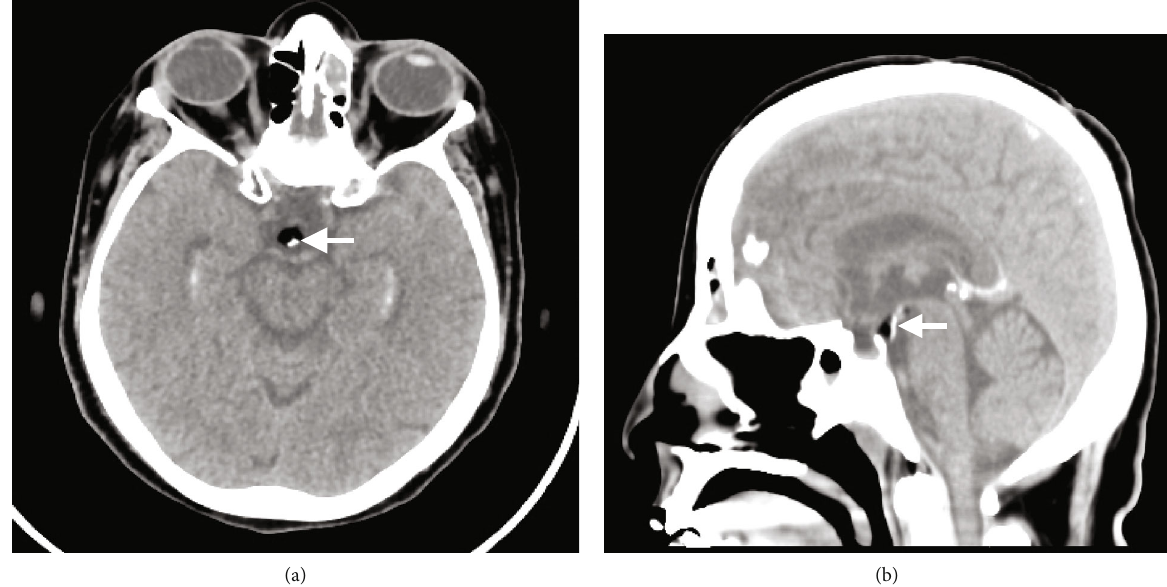
Figure 2: (a) Axial brain CT. (b) Coronal brain CT. (a) and (b) The images demonstrate a small fat-density lesion with punctate calci fi cation, representing a hypothalamic